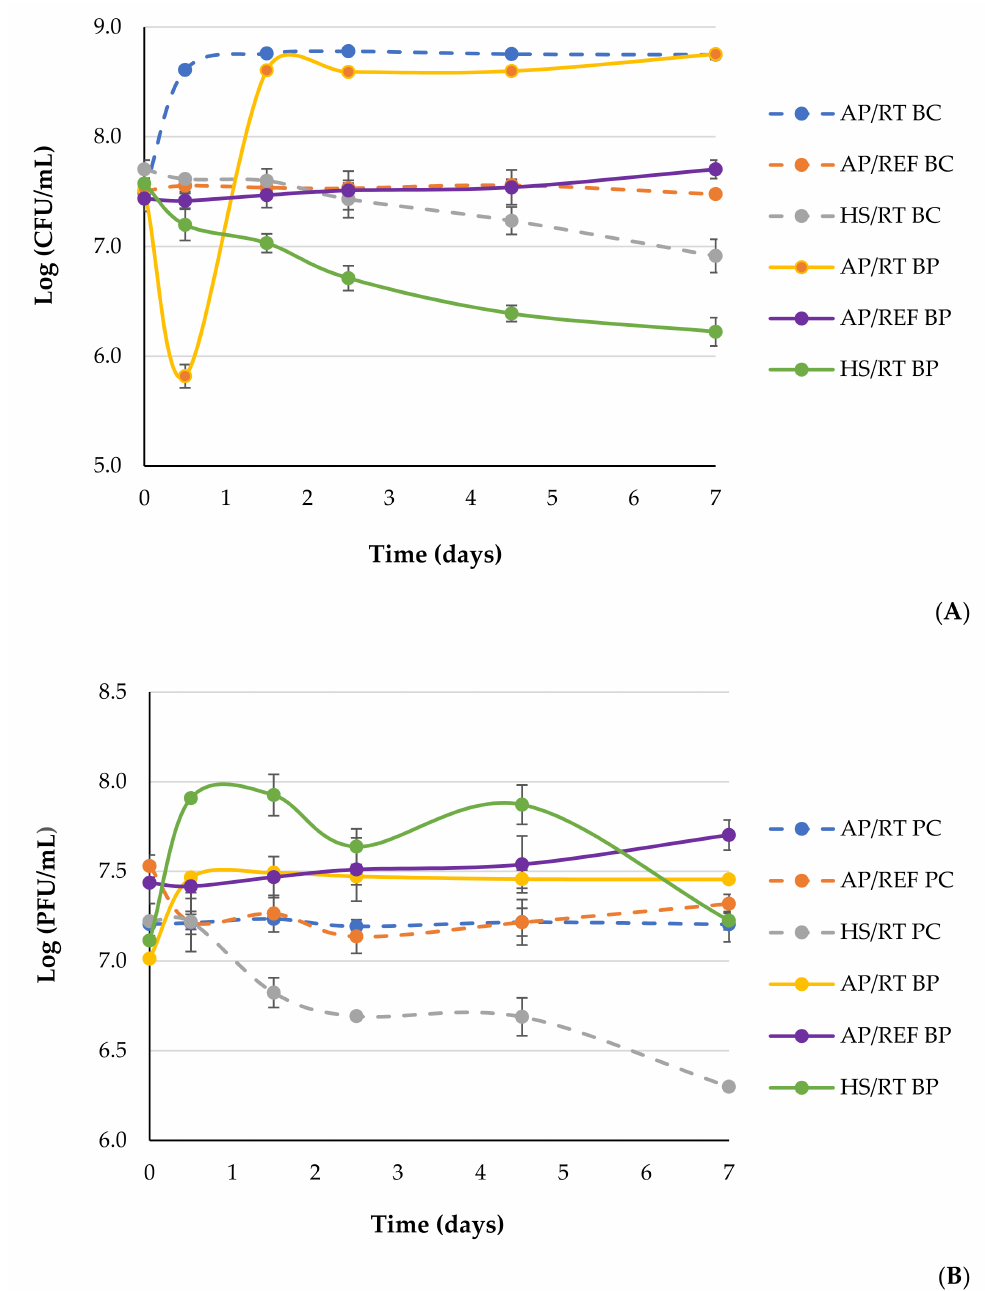
Figure 4. Bacterial counts of E. coli with phage phT4A ( A ) and phage phT4A viability ( B ) during the 7 days of storage at different conditions: under atmospheric pressure at room temperature (AP/RT) and 4 ◦ C (AP/REF) and 75 MPa pressure at (HS/RT). ( A ) Bacterial concentration: BC, bacteria control; BP, bacteria plus phage. ( B ) Phage concentration: PC, phage control; BP, bacteria plus phage. Values represent the mean of three experiments; error bars represent the standard deviation. Dashed lines: controls and solid lines: test